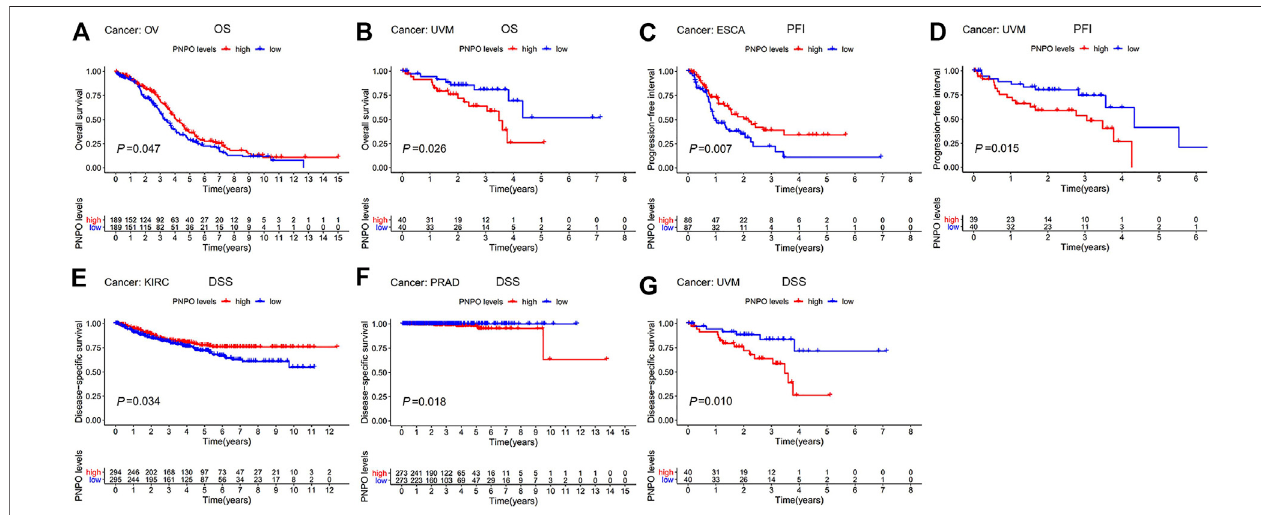
FIGURE 3 | Patient survival period analysis. (A,B) Kaplan – Meier analysis of the association between PNPO expression and OS in OV (A) , and UVM (B) . (C,D) Kaplan – Meier analysis of the correlation between PNPO expression and PFI in ESCA (C) , and UVM (D) . (E,G) Kaplan – Meier analysis of the association between PNPO expression and DSS in KIRC (E) , PRAD (F) , and UVM (G) . The red linerepresentshigh PNPO expression and theblue linerepresentslow PNPO expression. OS, overall survival; PFI, progression-free interval; DSS, disease-speci fi c survival.